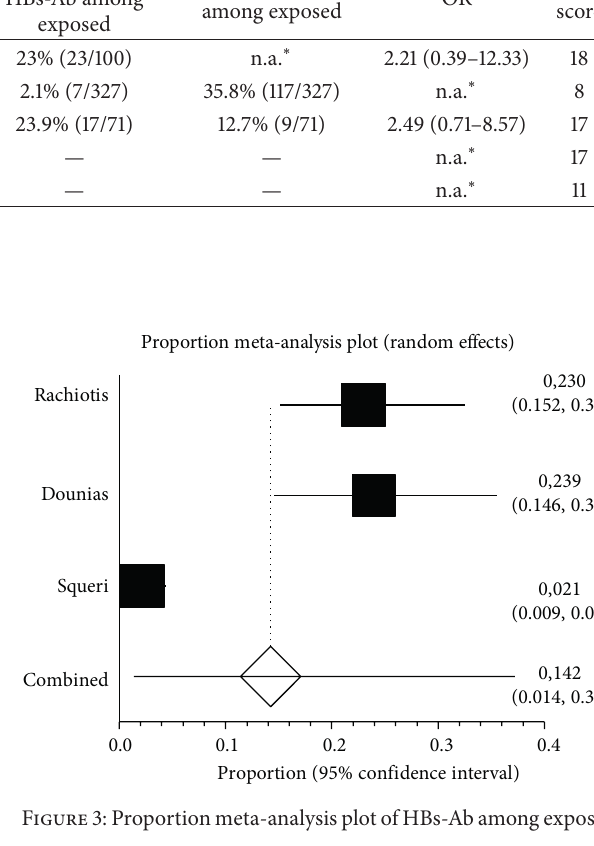
Figure 2: Proportion meta-analysis plot of HBs-Ag among exposed.